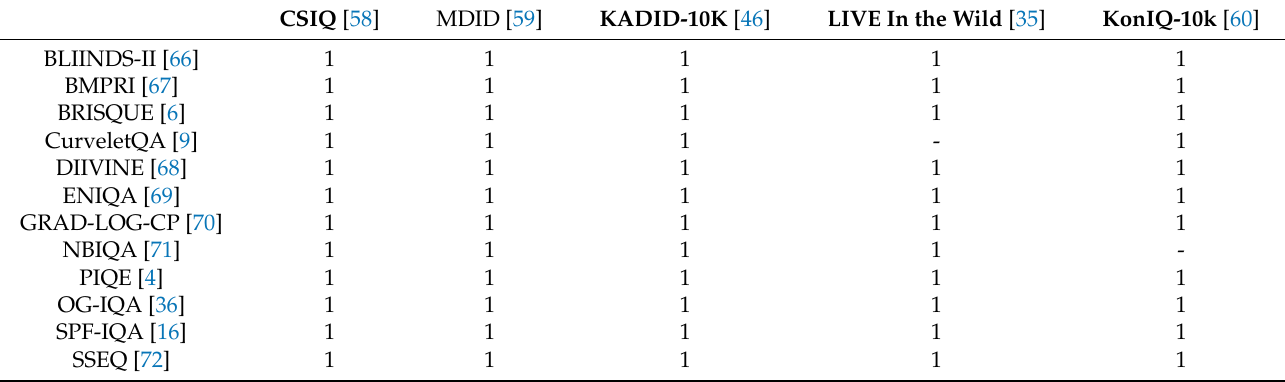
Table 7. One-sided t -test. Symbol ‘1’ means that the proposed GSF-IQA method is statistically better than the NR-IQA method in the row on the IQA benchmark database in the column. Symbol ‘-’ is used when there is no significant difference.